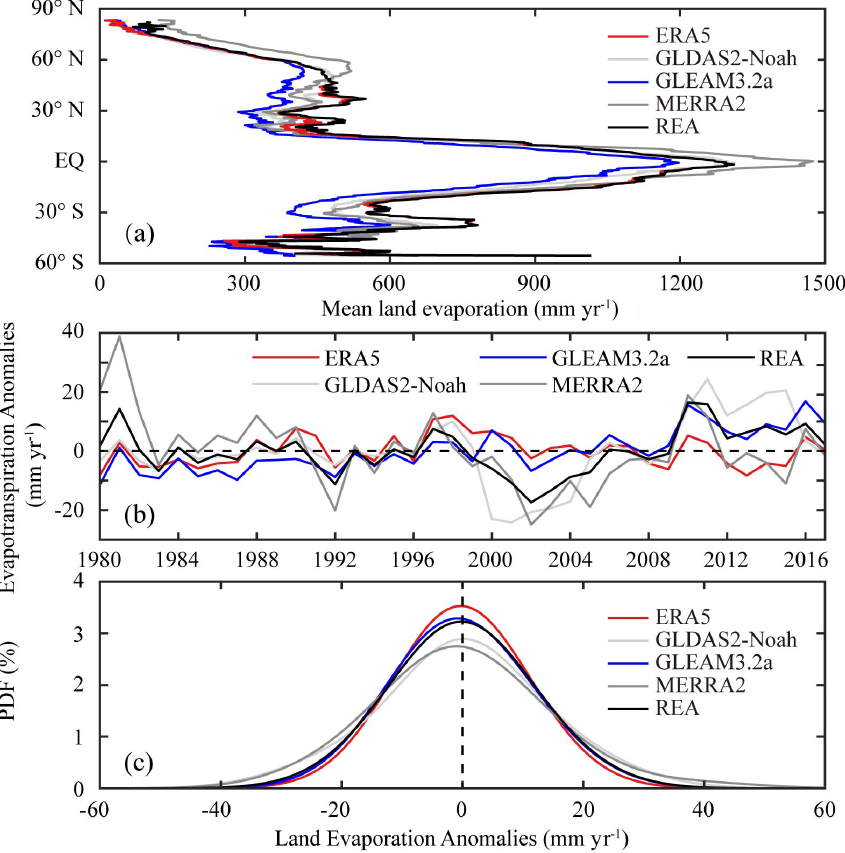
Figure 4. (a) Latitudinal distribution of mean land evaporation from five datasets, (b) time series (1980–2017) and (c) probability distribution of annual land evaporation anomalies from five ET products. The bandwidth of the kernel smoothing window was set to 10.